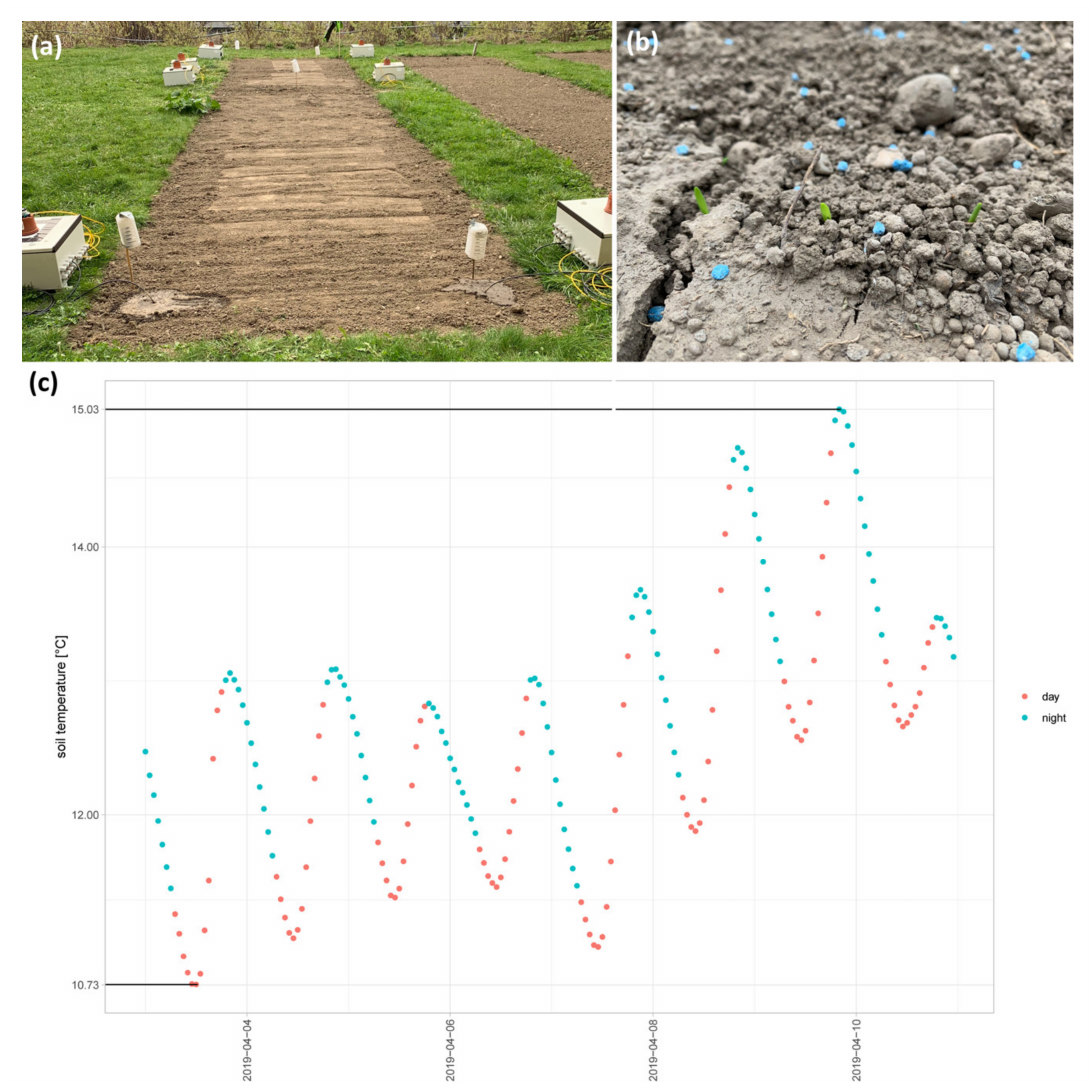
Figure 1. Setup of the field experiment to determine the germination temperature for the barley summer cultivar Golden Promise (GP). ( a ) Seven sensors were used to measure the temperature at different soil depths. ( b ) The shoot was observed seven days after 5000 GP seeds were sown. ( c ) Mean values of data received from five sensors from a soil depth of − 20